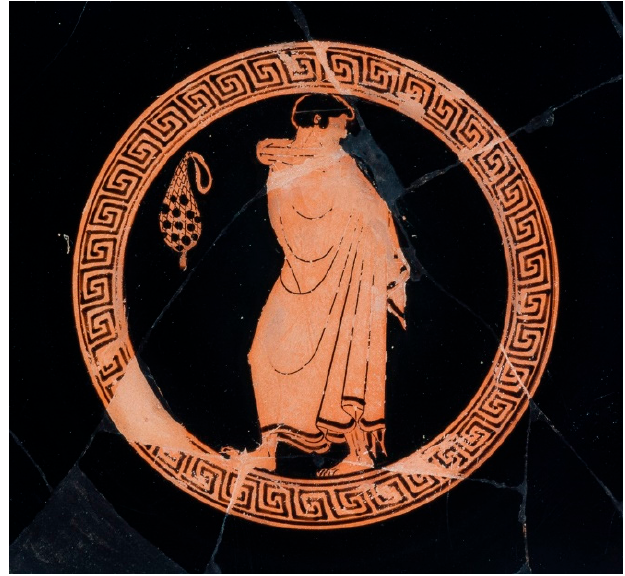
Figure 7. Interior of a kylix attributed to Makron. Munich, Antikensammlungen 2658. Photo courtesy Staatliche Antikensammlungen und Glyptothek München. Photograph by Renate Kühling. Used by permission. 480/70 BCE.